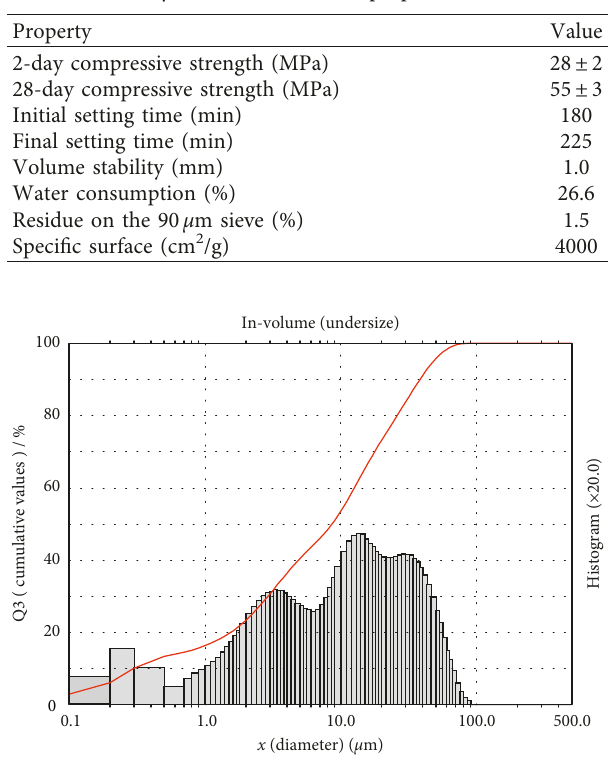
Table 2: Physical and mechanical properties of cement.